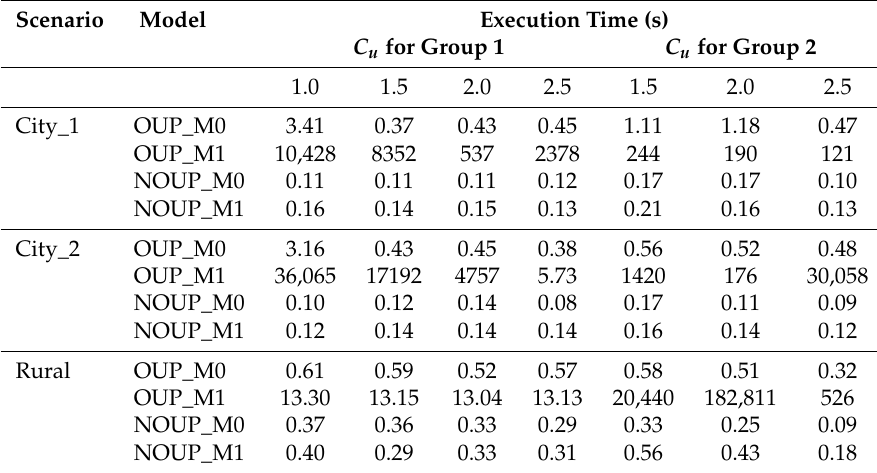
Table 8. Execution